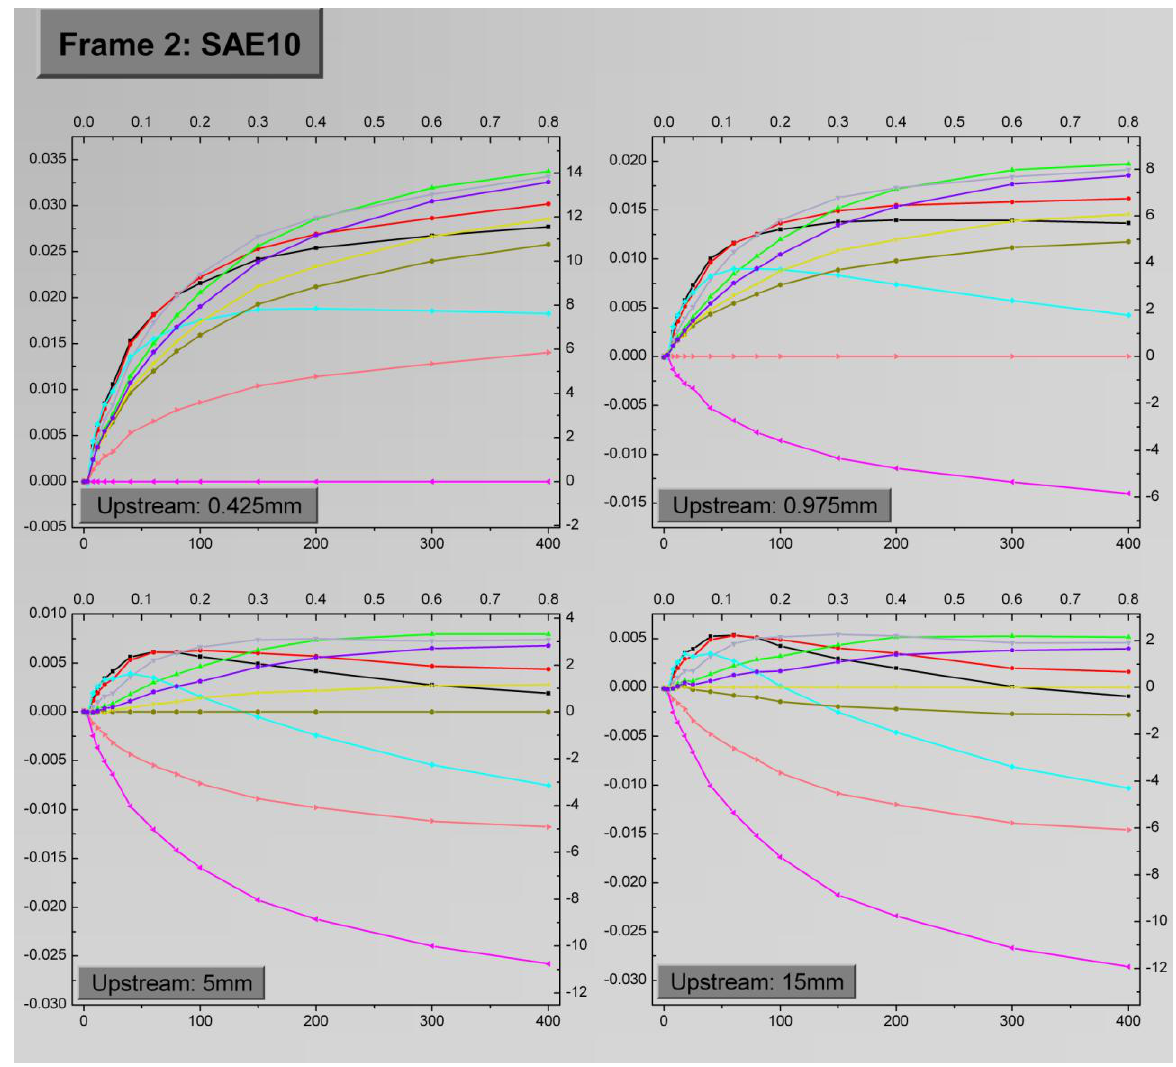
Figure 9. Frame 2 which describes sensor operation for the engine oil with viscosity SAE10. The correspondence between D loc and the line colors is